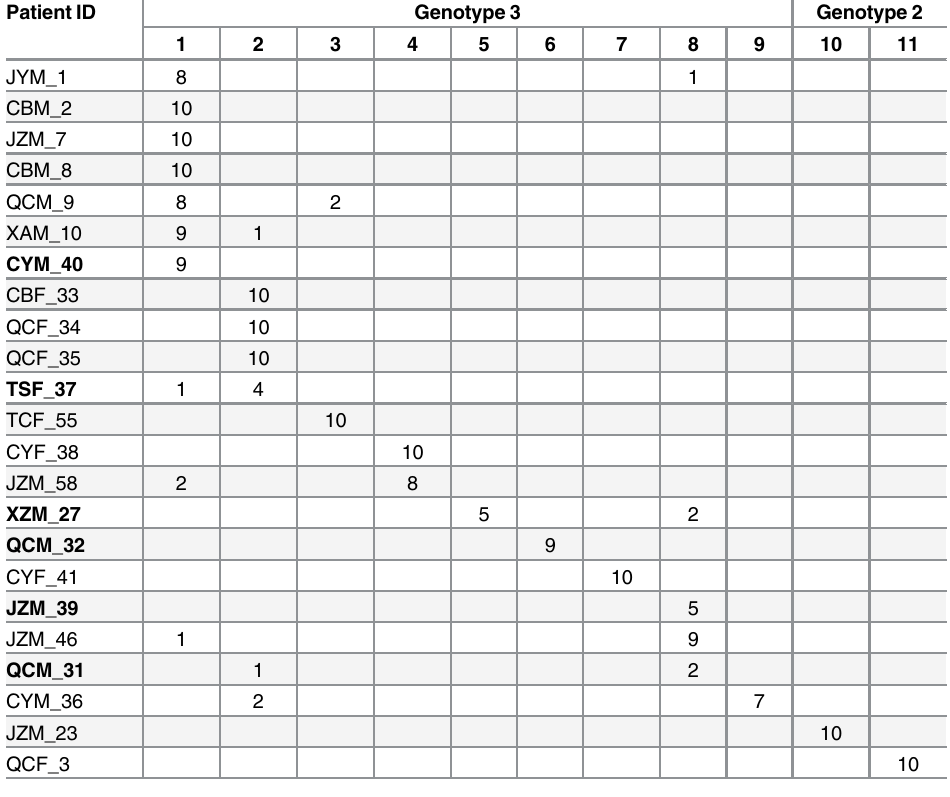
Patients with recombinant sequences are in